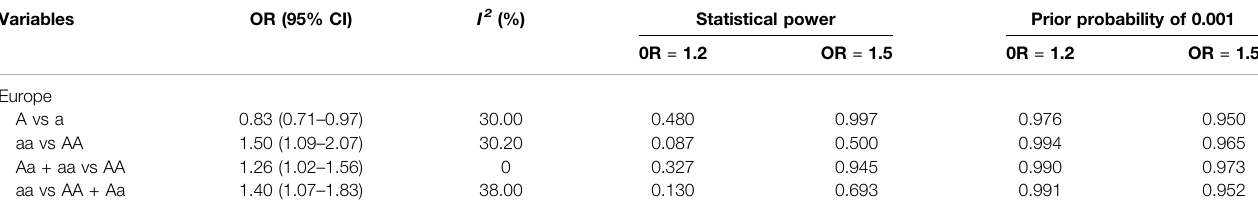
TABLE 14 | False-positive report probability values for the statistically signi fi cant associations in the current meta-analysis.